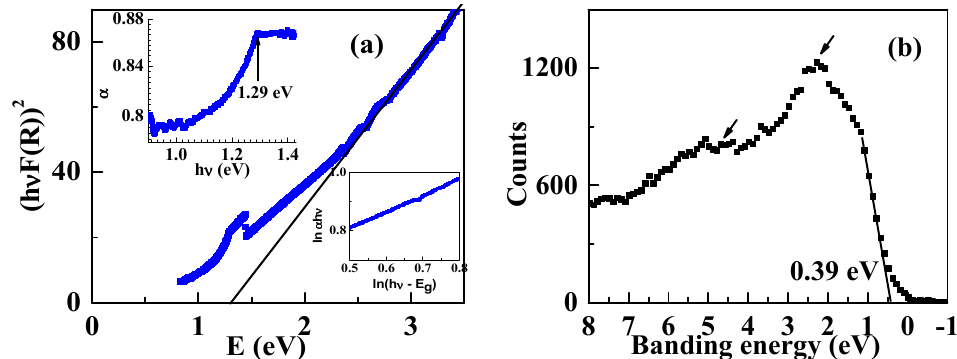
Figure 5. ( a ) [ hvF ( R )] 2 versus the energy E , and the upper inset is the corresponding absorption curve, Figure 5. ( a ) 2 )]([ RhvF versus the energy E , and the upper inset is the corresponding absorption and the lower inset is ln ( α hv ) versus ln ( hv − E g ) ; ( b ) the valence band of RuSb 2 + )ln( Ehv − curve, and the lower inset is )ln( hv α versus ; ( b ) the valence band of RuSb 2+ . g